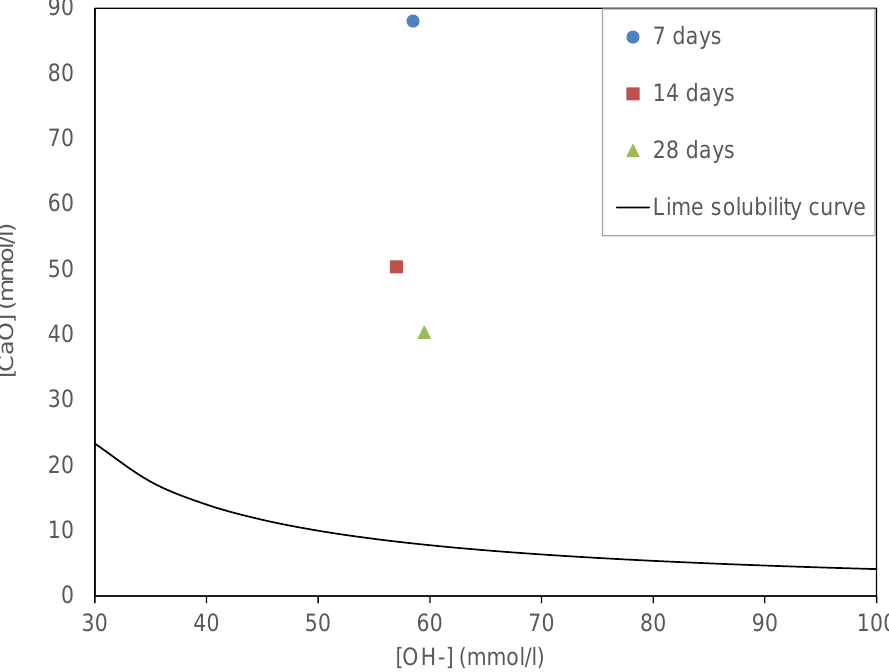
Figure 2. Frattini test results of GP at 7, 14 and 28 days.